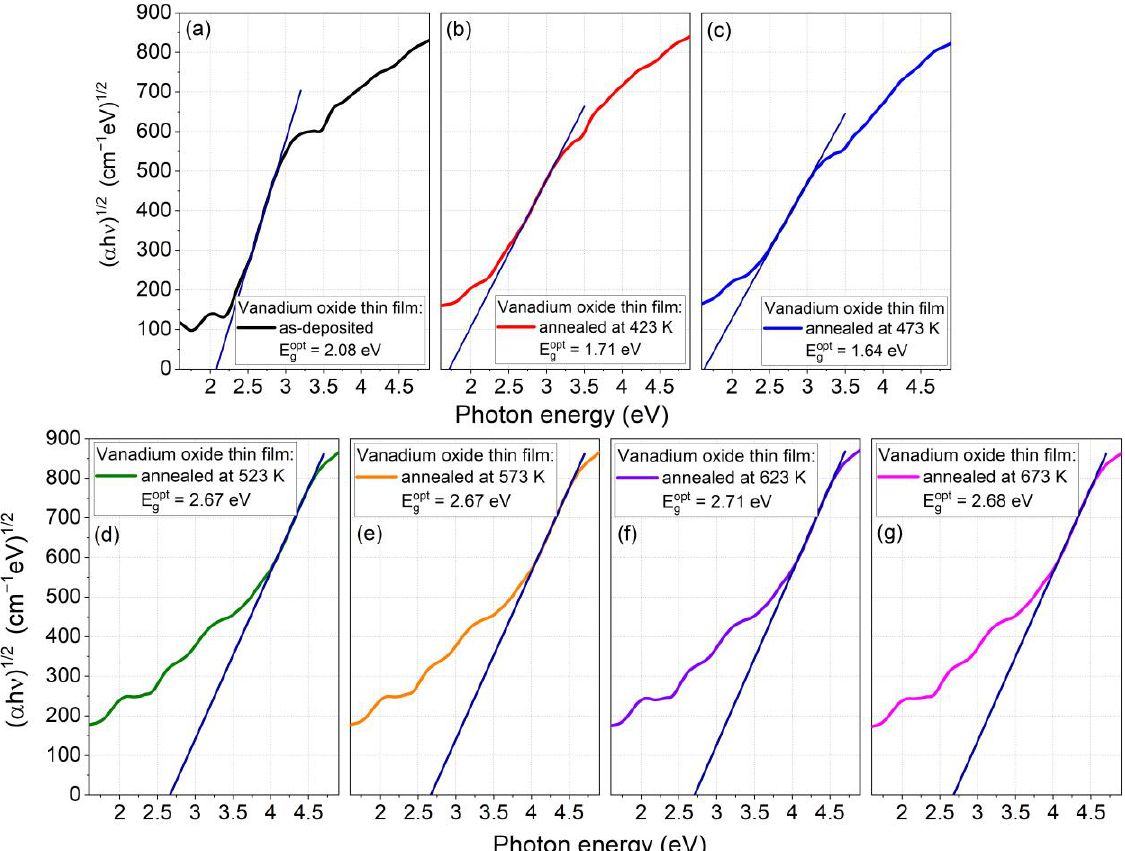
Figure 5. The determination of the optical band gap energy of V 2 O 5 thin films annealed at various temperatures: (a) as deposited, (b) 423 K, (c) 473 K, (d) 523 K, (e) 573 K, (f) 623 K and (g) 673 K.